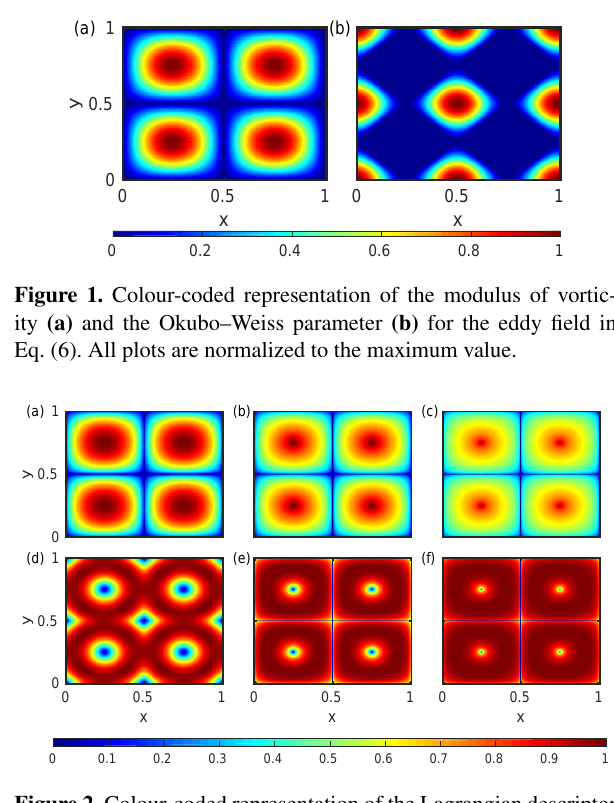
Figure 2. Colour-coded representation of the Lagrangian descriptor M V (a) – (c) and the Lagrangian descriptor M (d) – (f) for the eddy field in Eq. (6) with τ chosen as 0.5 (a, d) , 25 (b, e) and 100 (c, f) . All plots are normalized to the maximum value.